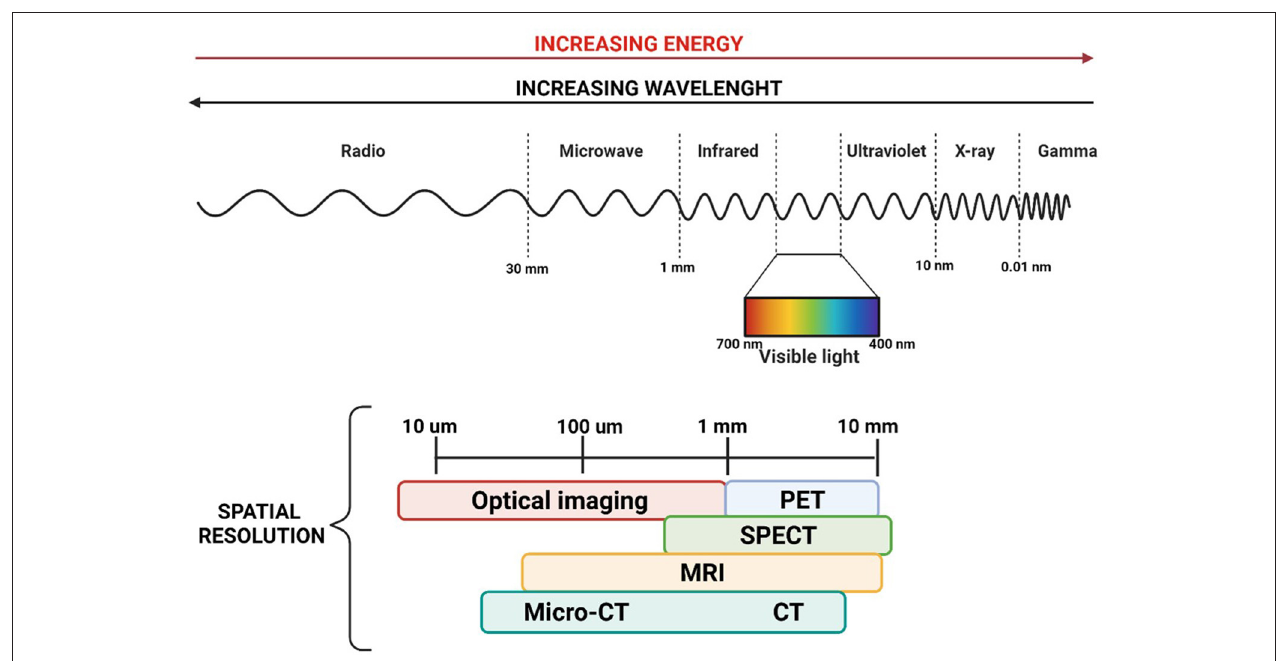
FIGURE 1 | Image of the electromagnetic spectrum and the associated wavelength and energies, with a focus on the spatial resolution of the dominant medical imaging modalities. TC, computer tomography; MRI, magnetic resonance imaging; SPECT, single-photon emission computed tomography; PET, positron emission